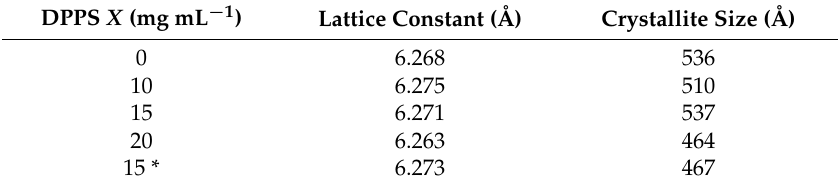
Table 2. XRD parameters of 100 of the MAPbI 3 /(DPPS) ( X mg mL − 1 ) perovskite solar cells.